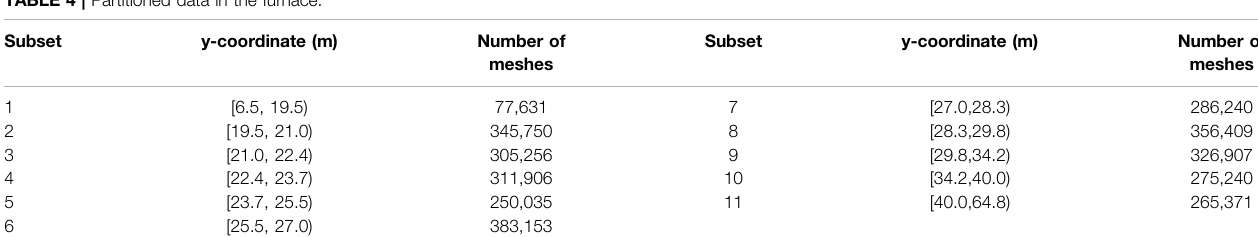
TABLE 4 | Partitioned data in the